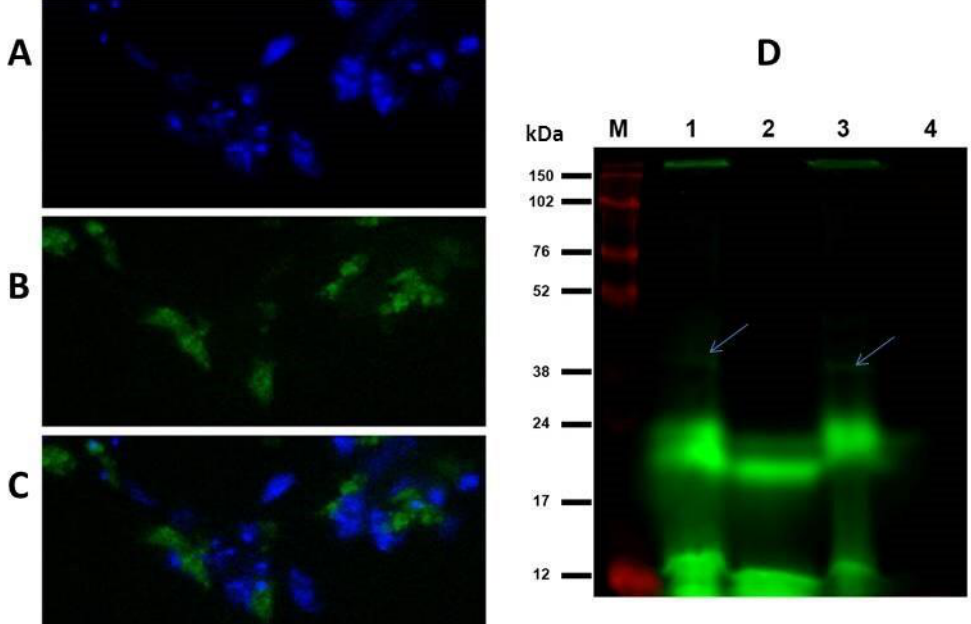
Figure 1. Detection of TGase activity in cultured promastigotes of L. infantum in vivo ( A – C ) and in vitro ( D ). ( A ) DAPI-stained nuclei of the parasites. ( B ) Fluorescein-cadaverine (FC) labelling of indigenous proteins via TGase activity. ( C ) Merged photo of A and B. Fluorescence was detected by Nikon Microphot FXA fluorescent microscope ( × 100 magnification). ( D ) 15% SDS-PAGE of L. infantum promastigotes lysate, labelled with FC. The green bands show excitation of the FC, and the red bands denote excited Cy5, which labels the molecular-mass marker. Molecular Imager System PHAROS Bio-Rad FX and software Quantity One 1-D were used for gel analysis. From left to right: lane M — molecular-mass marker; lane 1 — parasite extract + FC + dimethyl casein (arrows); lane 2 — parasite extract + FC; lane 3 — parasite extract + FC + dimethyl casein+ putrescine; and lane 4 — dimethyl casein alone (no fluorescence).